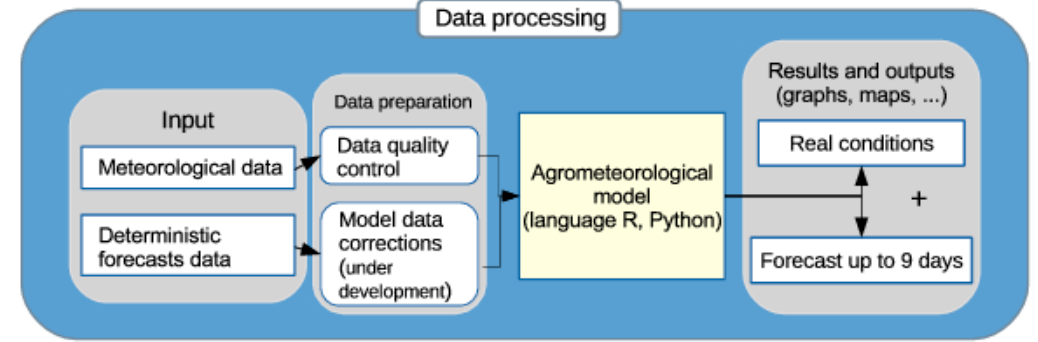
Figure 3. Diagram of data processing in forecast mode of the AVISO agrometeorological model run.